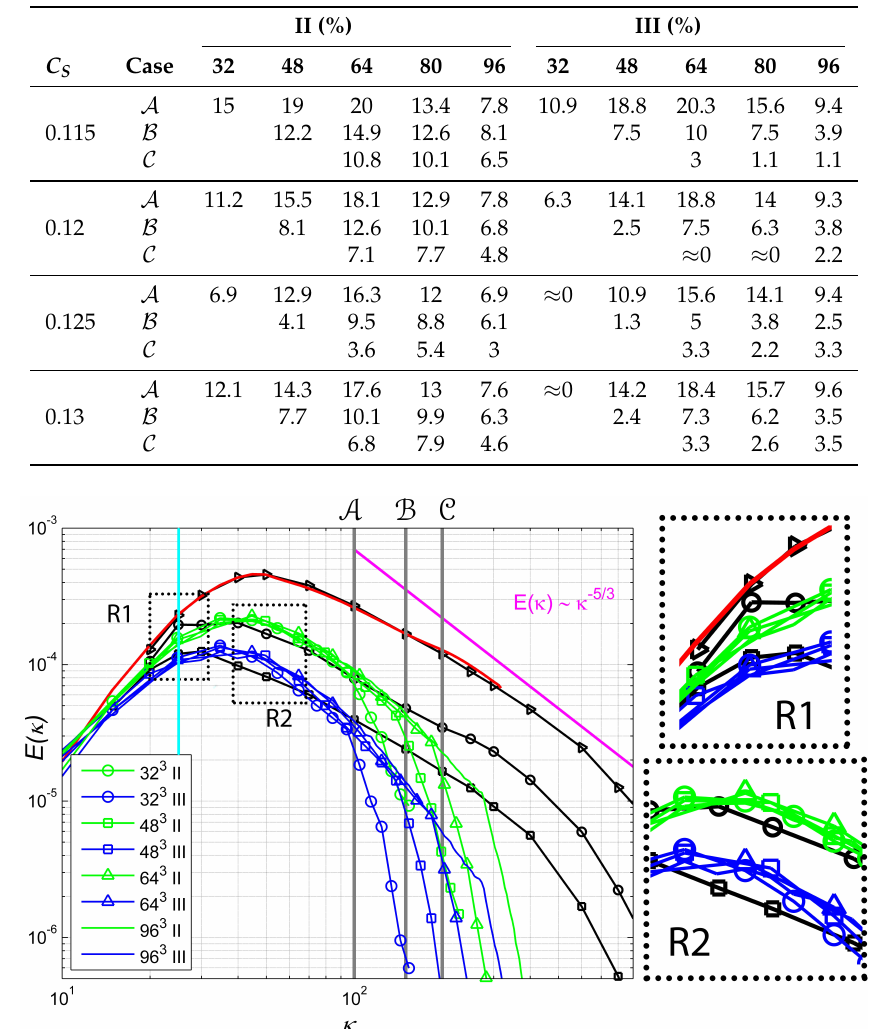
Figure 9. Changes in the energy spectra with grid resolution for ECNS and C S =